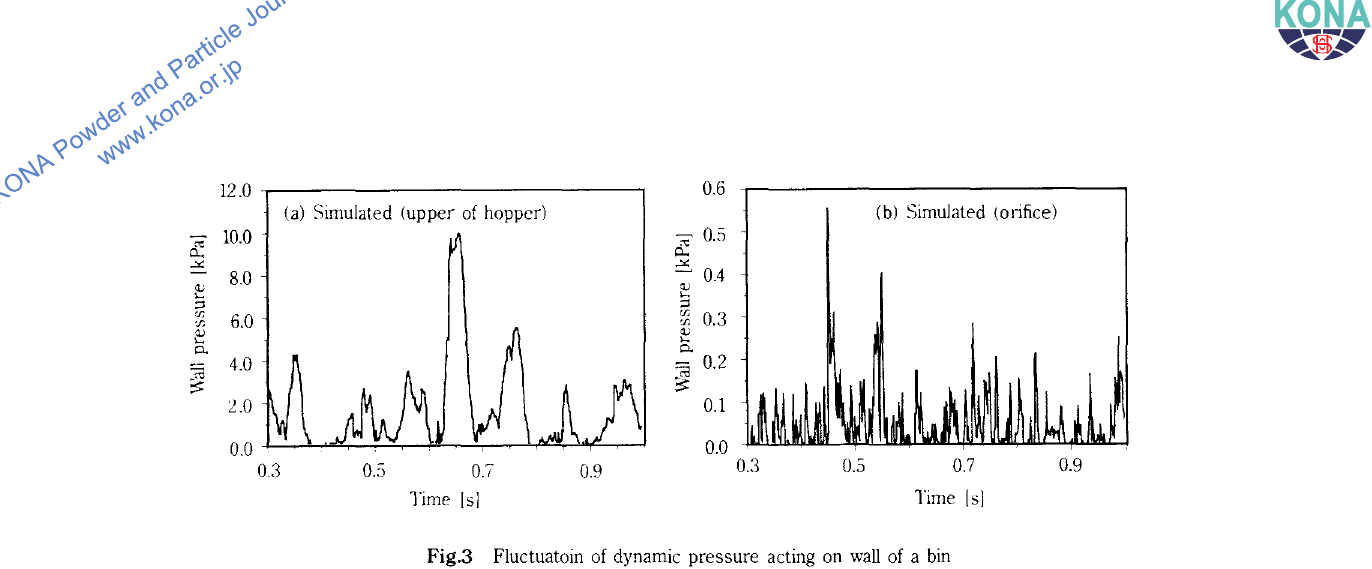
Fig.3 Fluctuatoin of dynamic pressure acting on wall of a